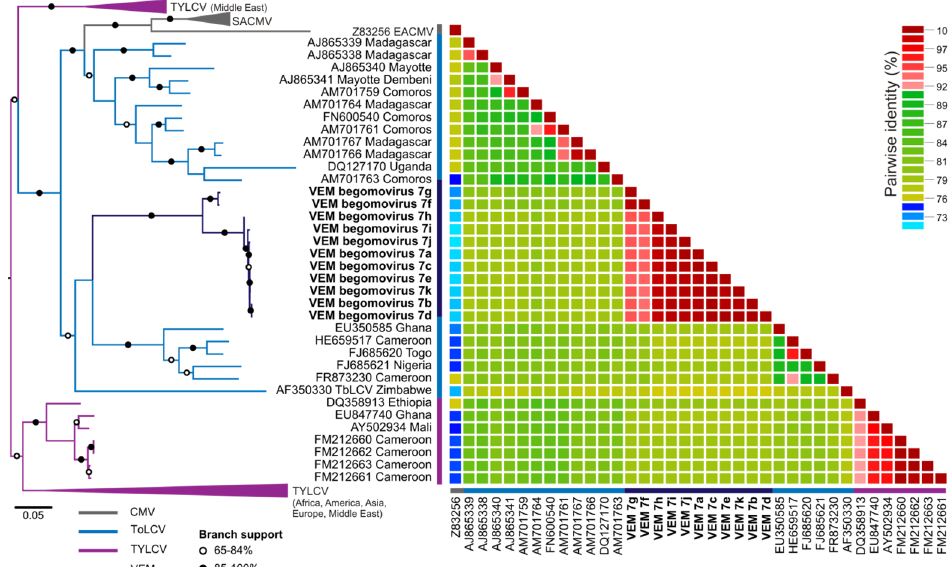
Figure 2. Maximum likelihood (ML) phylogenetic tree ( left ) and two-dimensional color-coded matrix depicting genome-wide pairwise identities ( right ) among genomes related to tomato leaf curl virus (ToLCV) detected through the vector-enabled metagenomic (VEM; dark blue) approach used in this study and related sequences. The ML tree includes sequences representing ToLCV (blue), tomato yellow leaf curl virus (TYLCV; purple), and cassava mosaic viruses (CMVs; grey). CMVs include South African cassava mosaic virus (SACMV) and East African cassava mosaic virus (EACMV). Branches with bootstrap support >85% are indicated with black circles, whereas branches exhibiting 60%-84% support are marked with a white circle. A list of sequences used for phylogenetic analysis is provided in Supplemental File S2. Genome-wide pairwise identities are shown for viral genomes related to ToLCV identified through VEM as well as the most closely-related sequences from Africa and the South-West Indian Ocean (SWIO) islands.